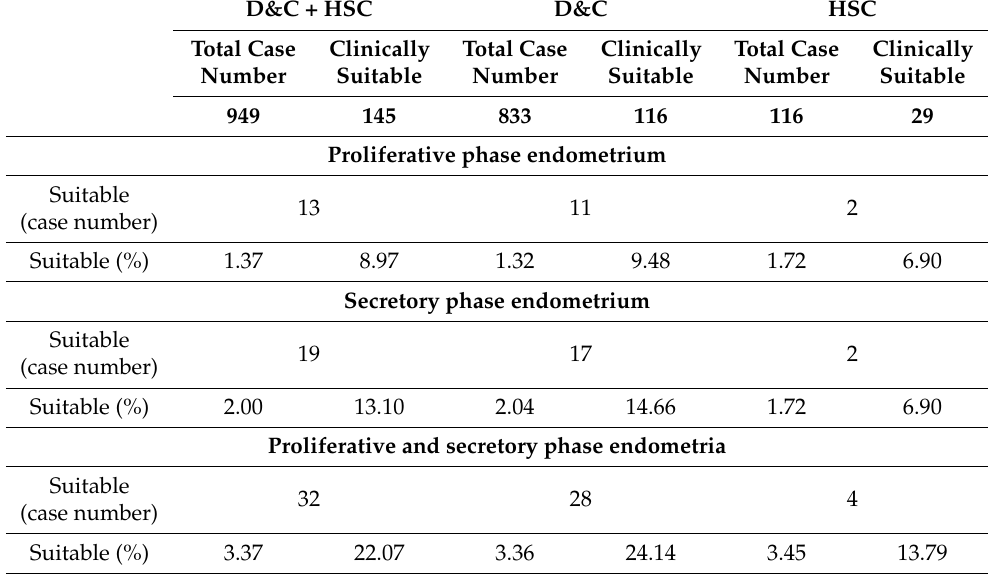
Table 12. Suitable